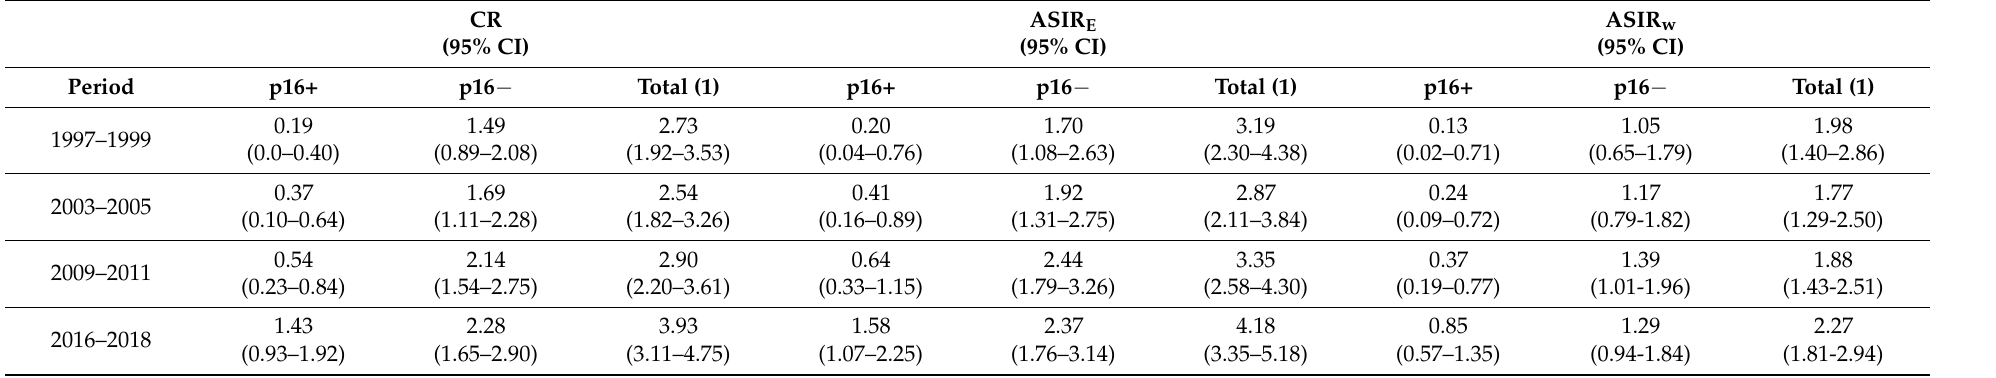
Table 4. Incidence rates of p16-positive and p16-negative oropharyngeal cancer, stratified by calendar